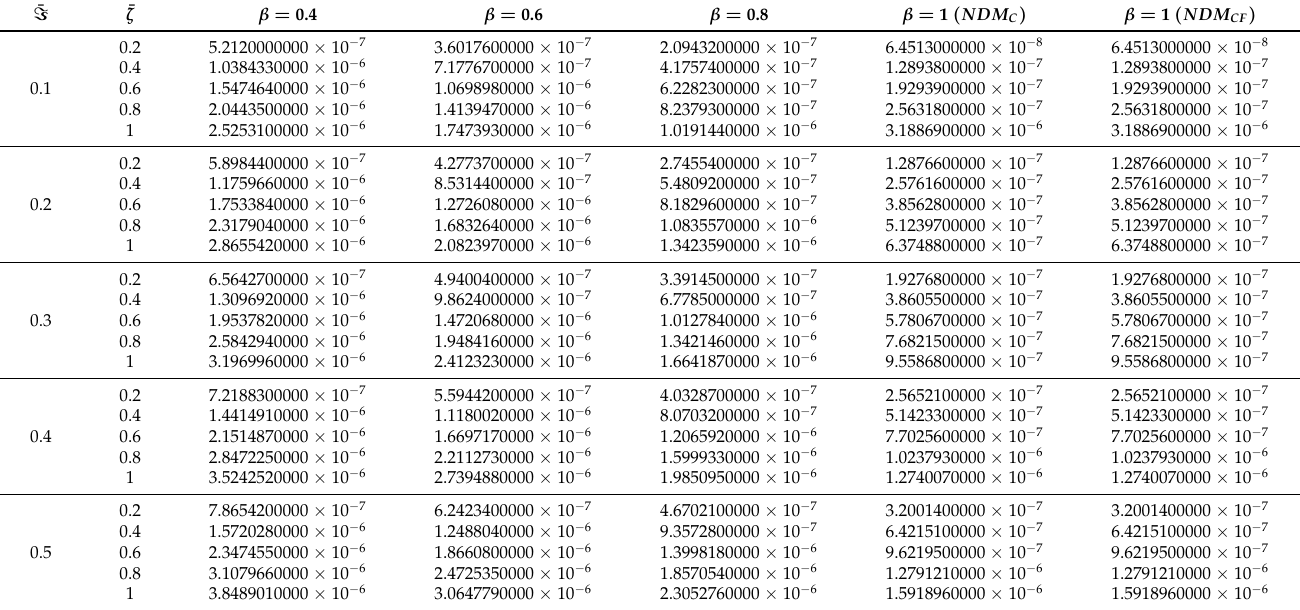
Table 2. Comparison at different fractional-order of β on the basis of error for Example